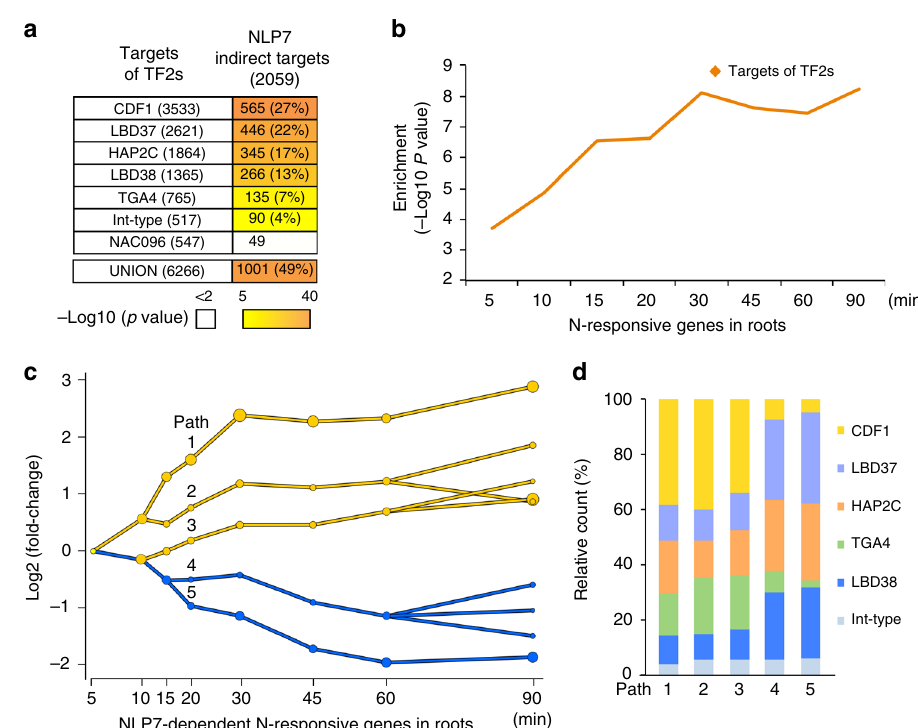
Fig. 4 NLP7-regulated secondary TFs mediate downstream effects of NLP7 in the N transcriptional cascade. a Intersection of direct targets of validated secondary TFs with NLP7 indirect targets (2059 genes). The signi fi cance ( p -value) of each intersection was calculated and − log10 ( p -value) was used for the heatmap. b Intersection of the union of direct targets of secondary TFs identi fi ed in root cells, with N-response genes in whole roots 19 . The signi fi cance ( p -value) of the intersection between direct targets of secondary TFs with each time point was calculated and − log10 ( p -value) was graphed. c DREM2 34 reconstructed RNA expression NLP7-dependent paths 90 min post N treatment. Each path corresponds to a set of genes that are co-expressed. Split nodes (yellow and blue circles) represent a temporal event where a group of genes co-expressed up to that point diverge in expression, most likely due to regulatory events. d The contribution of secondary TFs mediating each DREM2 path were assessed by intersecting genes from each path with genes induced or repressed by each secondary